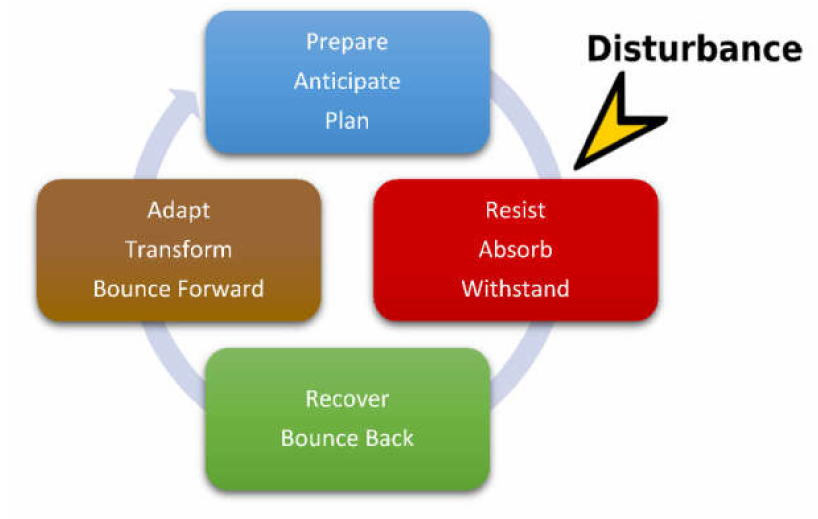
Figure 2. Presentation of key actions in a cycle (image based on [6]).